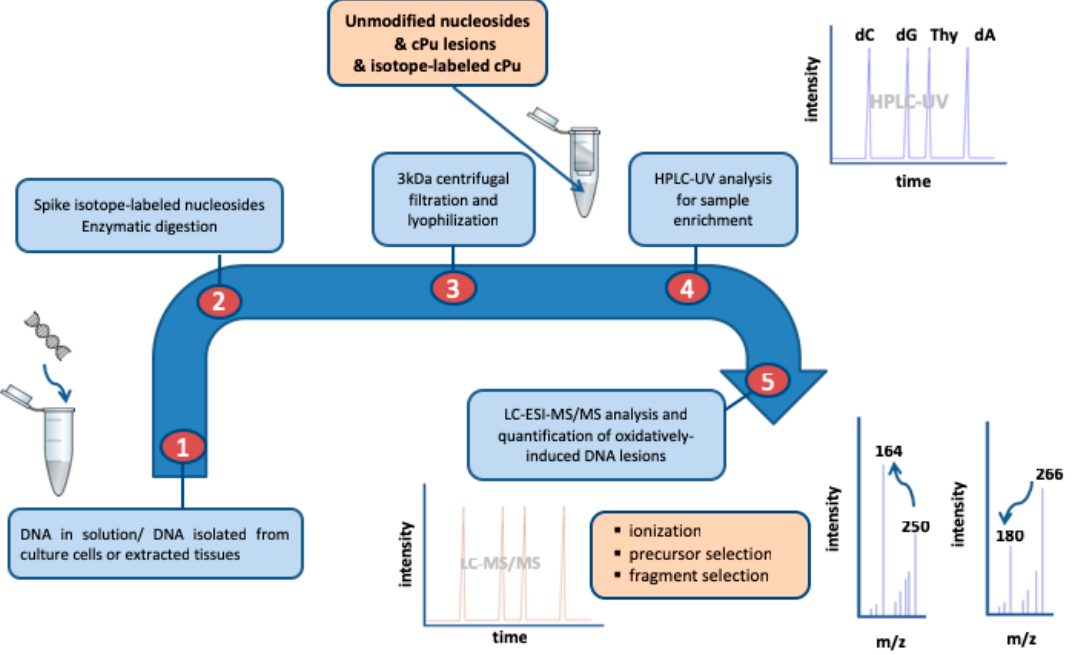
Figure 11. Workflow showing protocol steps for the quantification of cPu lesions via isotope